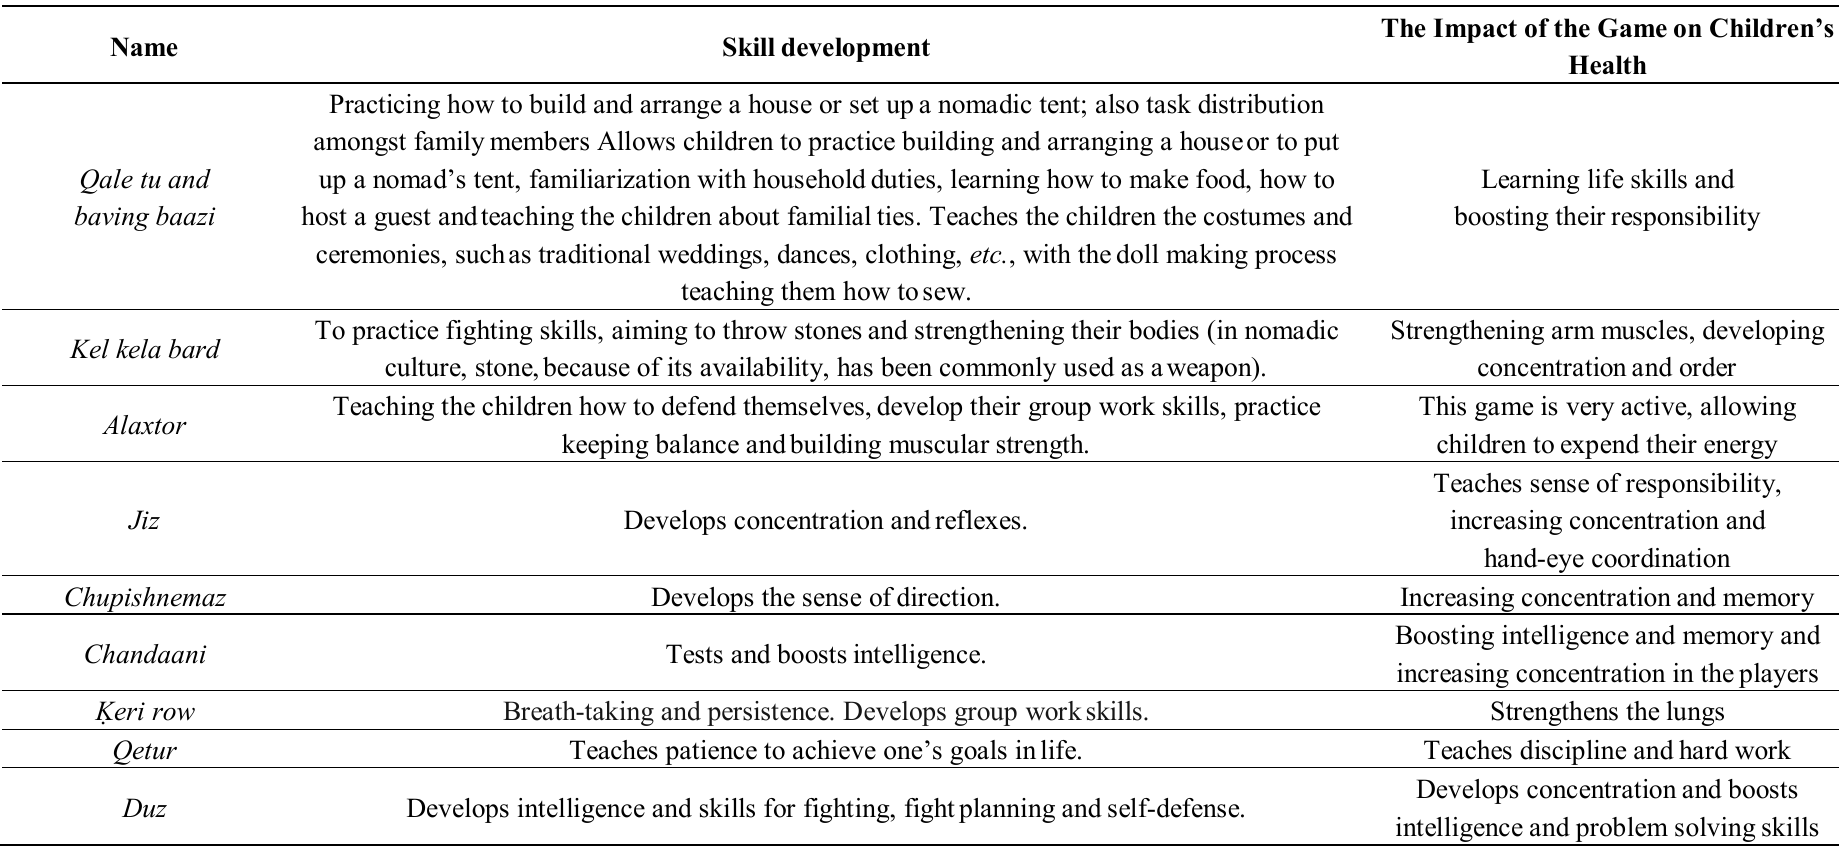
Table 2. Goals and effects of these native